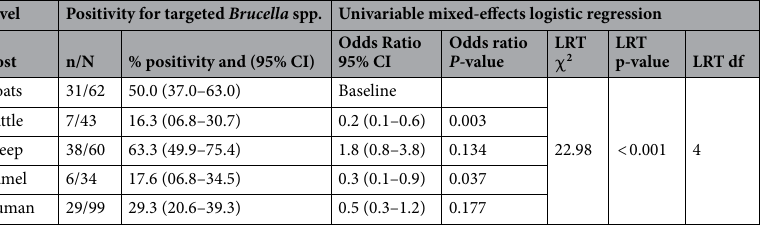
Table 6. Summary of mixed-effects logistic regression models of Brucella melitensis status in different host species. Location icc = 0.05. CI confidence interval, LRT χ 2 Likelihood Ratio Test Chi-square value, P-value according to Pearson Chi-square test, n number of positives, N total number